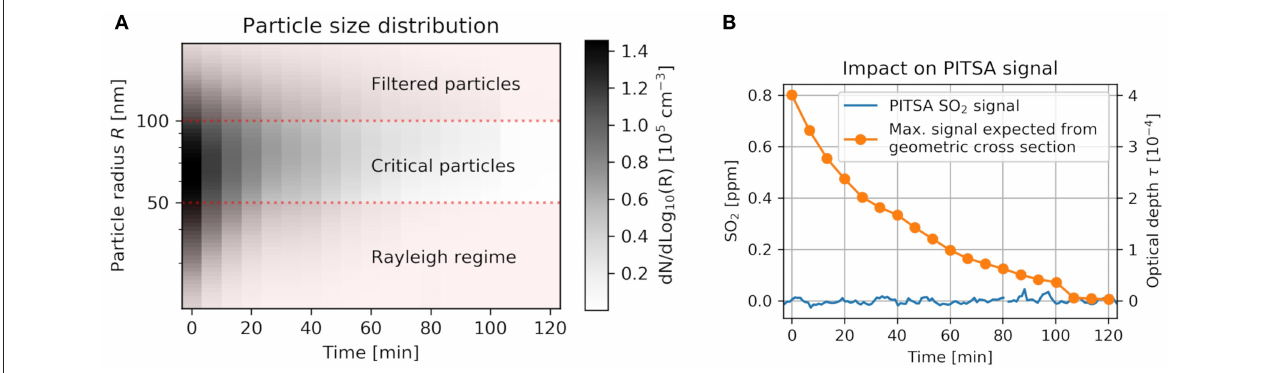
FIGURE 8 | Atmospheric simulation chamber experiment to investigate the impact of nano particles on PITSA measurements. (A) particle size distributions in the chamber, measured by an SMPS. Only aerosol in the “critical” size interval are of interest (see text). (B) time series of the PITSA signal, which is much lower than the expected signal, as estimated from the size distributions on the left, assuming geometric absorption cross sections ( σ p